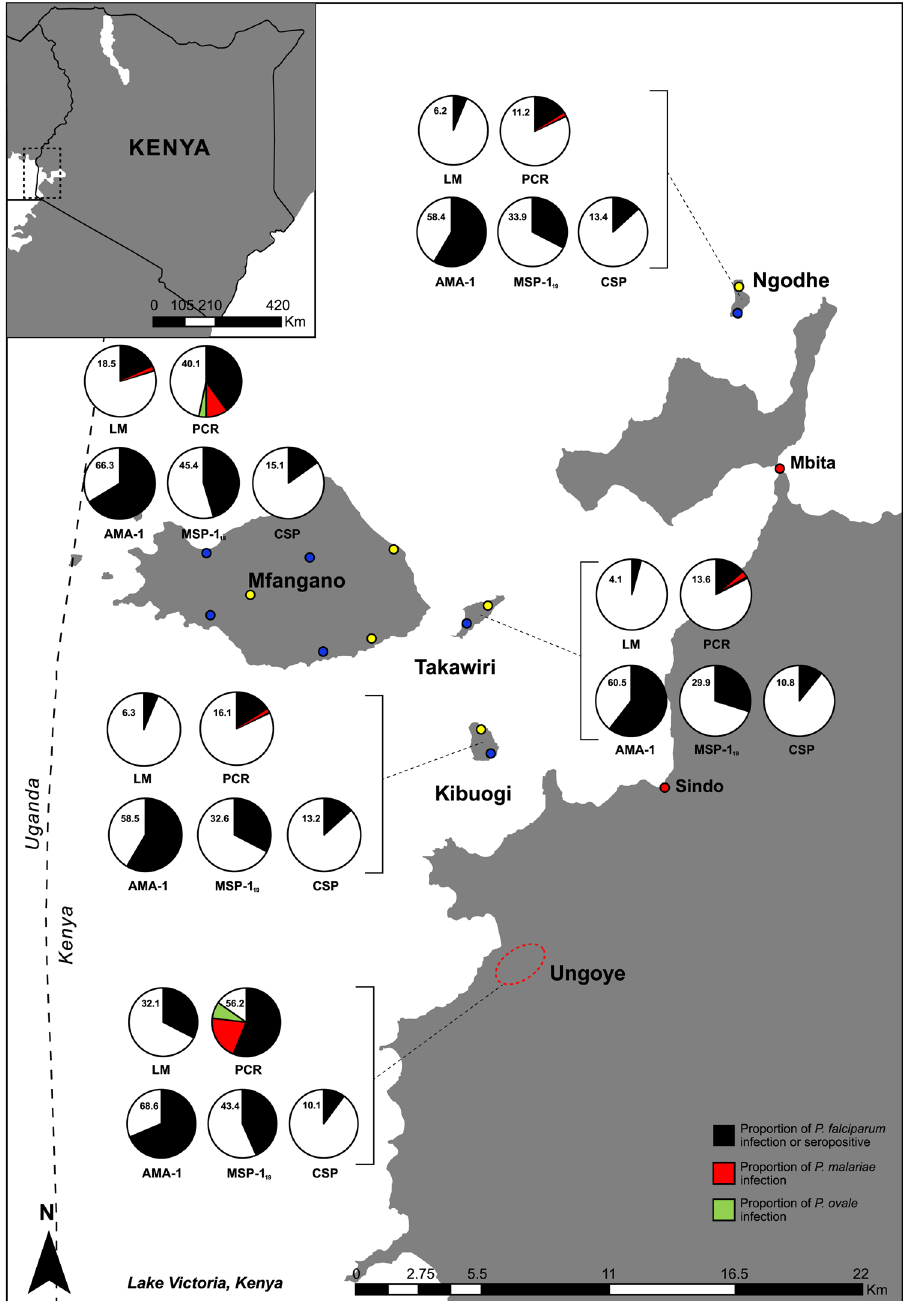
Figure 1. Map of the study area in Lake Victoria in western Kenya (inset) showing the proportion of Plasmodium spp. infection and P . falciparum seroprevalence. The population of three main areas were subjected in this study: mainland coastal village (Ungoye; area shown in red dashed line), large island (Mfangano) and three small islands (Takawiri, Kibuogi and Ngodhe). The black, red and green pies are proportions of P . falciparum , P . malariae and P . ovale , respectively. A number in each pie graph is the proportion of P . falciparum infection or seropositive. Yellow and blue circles pointed the surveyed catchment areas in January 2012 and August 2012, respectively. The most populated small towns are shown in red circle. LM is light microscopy and PCR is nested PCR. The map was created with ArcGIS software, version 10.4,